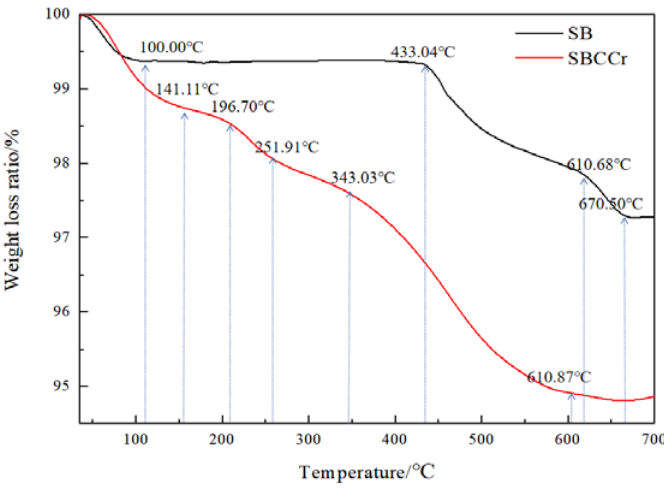
Figure 3. The TGA curve of sodium bentonite with and without catechol chromium catalyst.